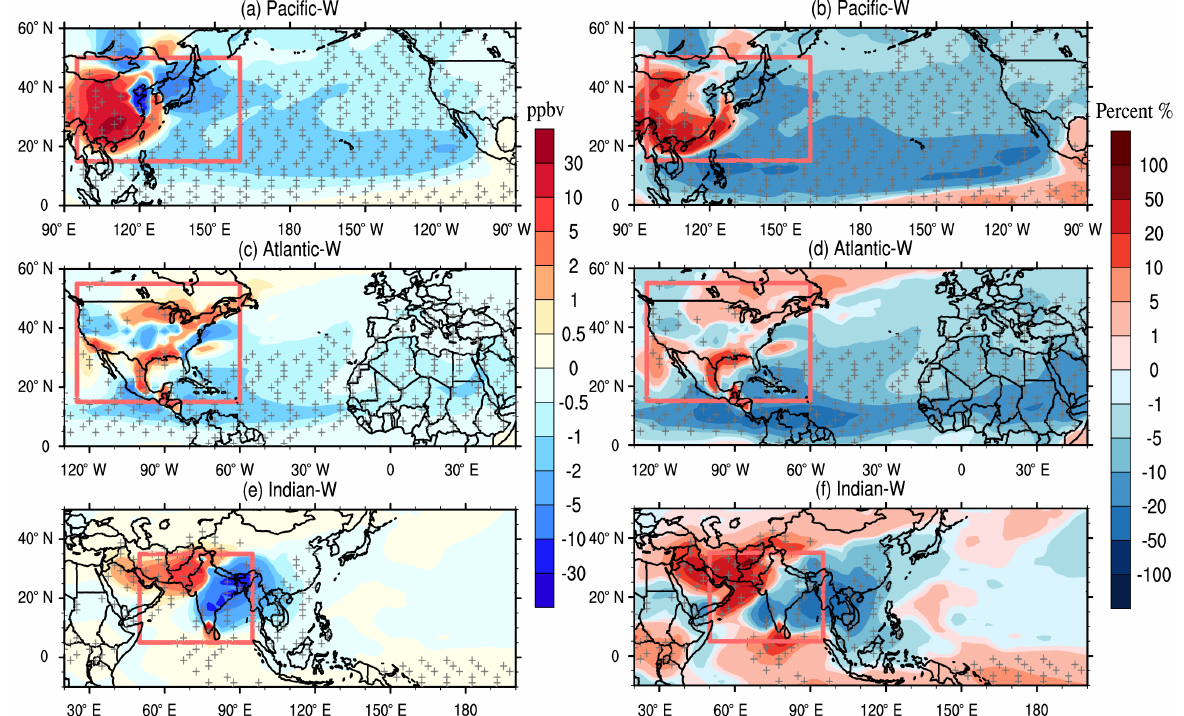
Figure 8. Panels (a, c, e) : difference in the surface concentration (ppbv) of a CO-like tracer emitted from (a) East Asia for Pacific-W, (c) North America for Atlantic-W, and (e) the South Asia for Indian-W relative to the CTRL in the boreal summer. Panels (b, d, f) : the percentage changes in the surface concentration of a CO-like tracer emitted from (b) East Asia for Pacific-W, (d) North America for Atlantic-W, and (f) South Asia for Indian-W relative to the CTRL in the boreal summer. Red polygons denote the region where the CO-like tracer is emitted from. The + symbol denotes areas in which the results are significant at the 0.05 level, evaluated using the Student’s t test and 20 years of